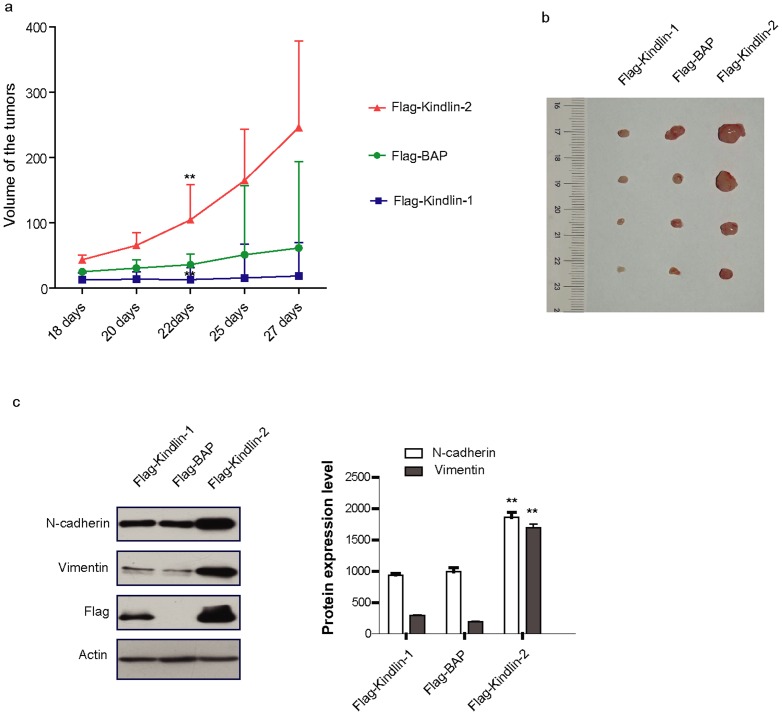
Kindlin-1 and Kindlin-2 oppositely regulate tumor growth in implanted xenograft.a. Tumor growth curve. The tumor volume of H1299-Flag-Kindlin-1 group is significantly smaller than the Flag-BAP group (p<0.01 as analyzed by Student's t test) at day 22 and meanwhile the volume of Flag-Kindlin-2 group is obviously larger than the Flag-BAP group (p<0.01 as analyzed by Student's t test). b. Tumors recovered from mice at day 27. c. Left panel: Determination of expressions of N-cadherin and Vimentin from tumor xenografts stably expressing Kindlin-1, Kindlin-2 and the control BAP by Western blot analyses. Right panel: Quantification of the relative protein levels for Kindlin-1- and Kindlin-2-regulated N-cadherin and Vimentin. Statistical analyses between different tumor groups were examined by Student's t test. ** represents for p<0.01.